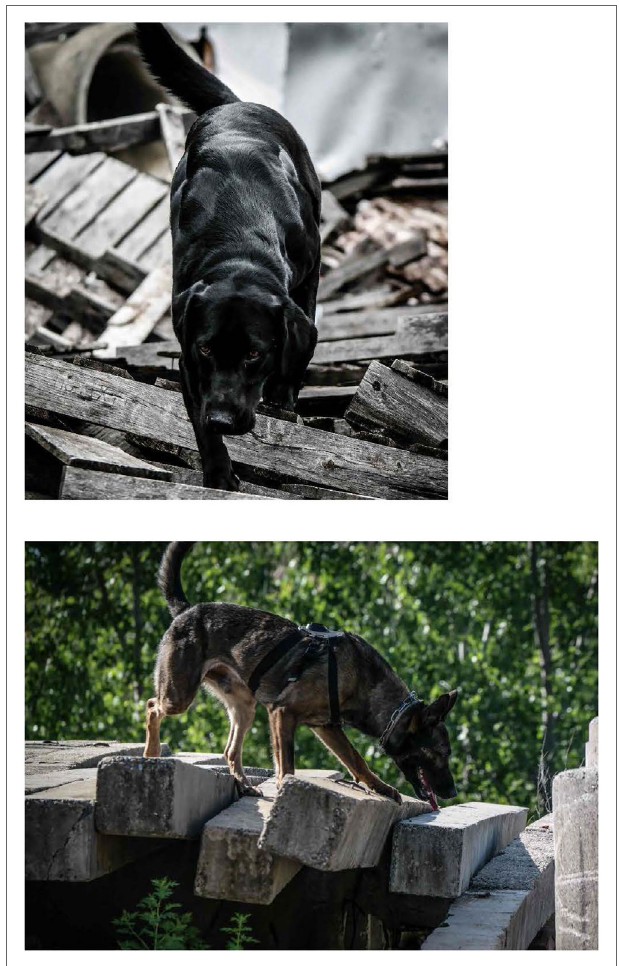
FigURe 4 | Disaster canines performing search work displaying the typical “nose down, tail up” posture associated with active olfaction. Photo credit to Tracy